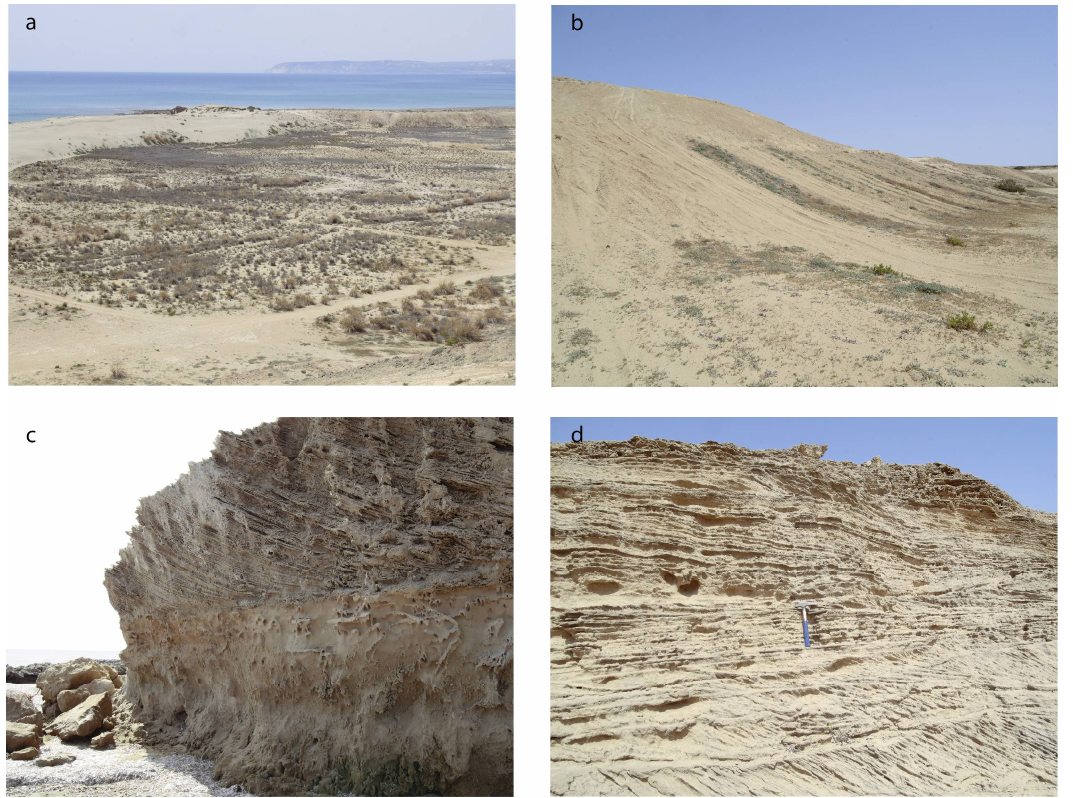
Figure 3. Western dune fields ( a ) primary dune development near the coastline. ( b ) Dune with height up to 48 m. ( c ) Lithified dune (aeolianite) near the coastline with clear evidence of erosion (weathered notch) and ( d ) Lithified with lamination.